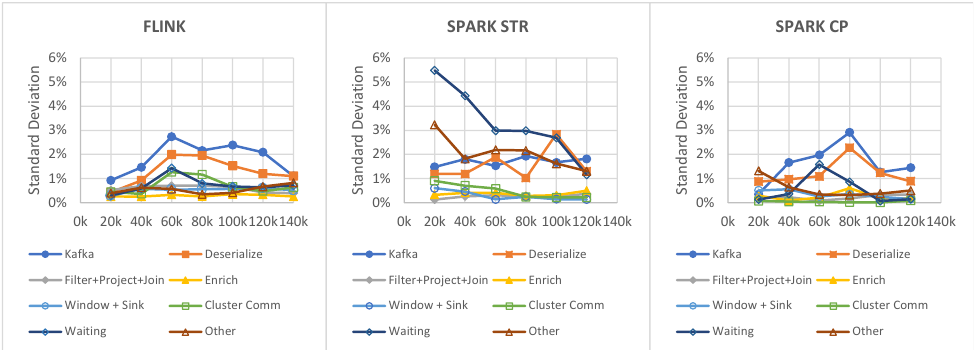
Figure 5. Profiling consistency.